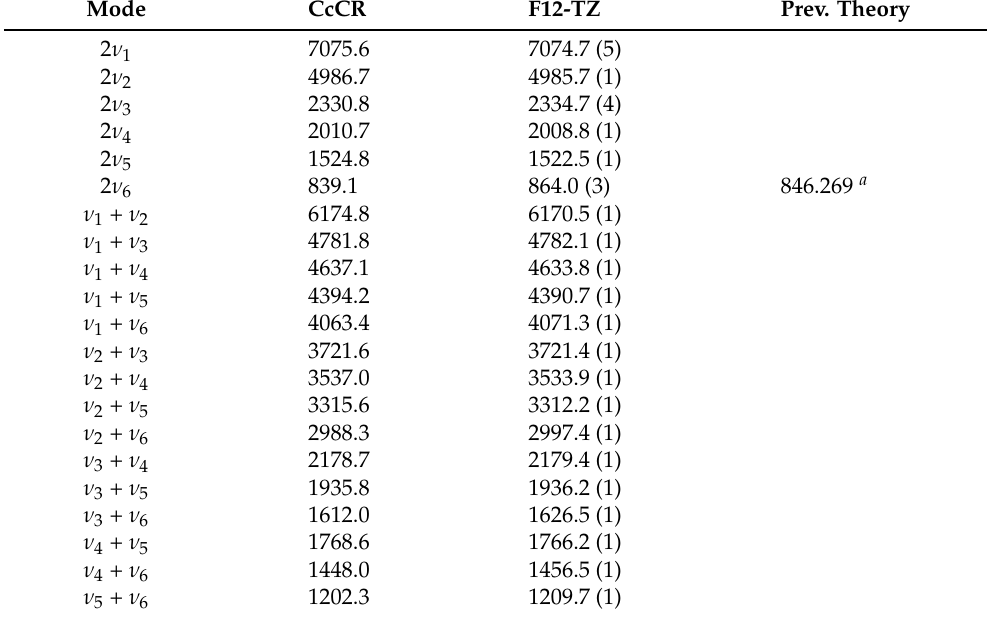
Table 6. Vibrational frequencies (cm − 1 ), and IR intensities (km/mol) given in parentheses for two- quanta bands of HOSH compared to the previous gas-phase